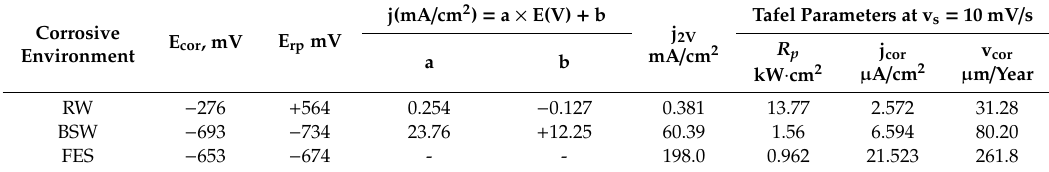
Figure 1. Cyclic voltammograms for the C45 sample. Table 5. Stimulated corrosion parameters for the C45 sample in the three corrosive